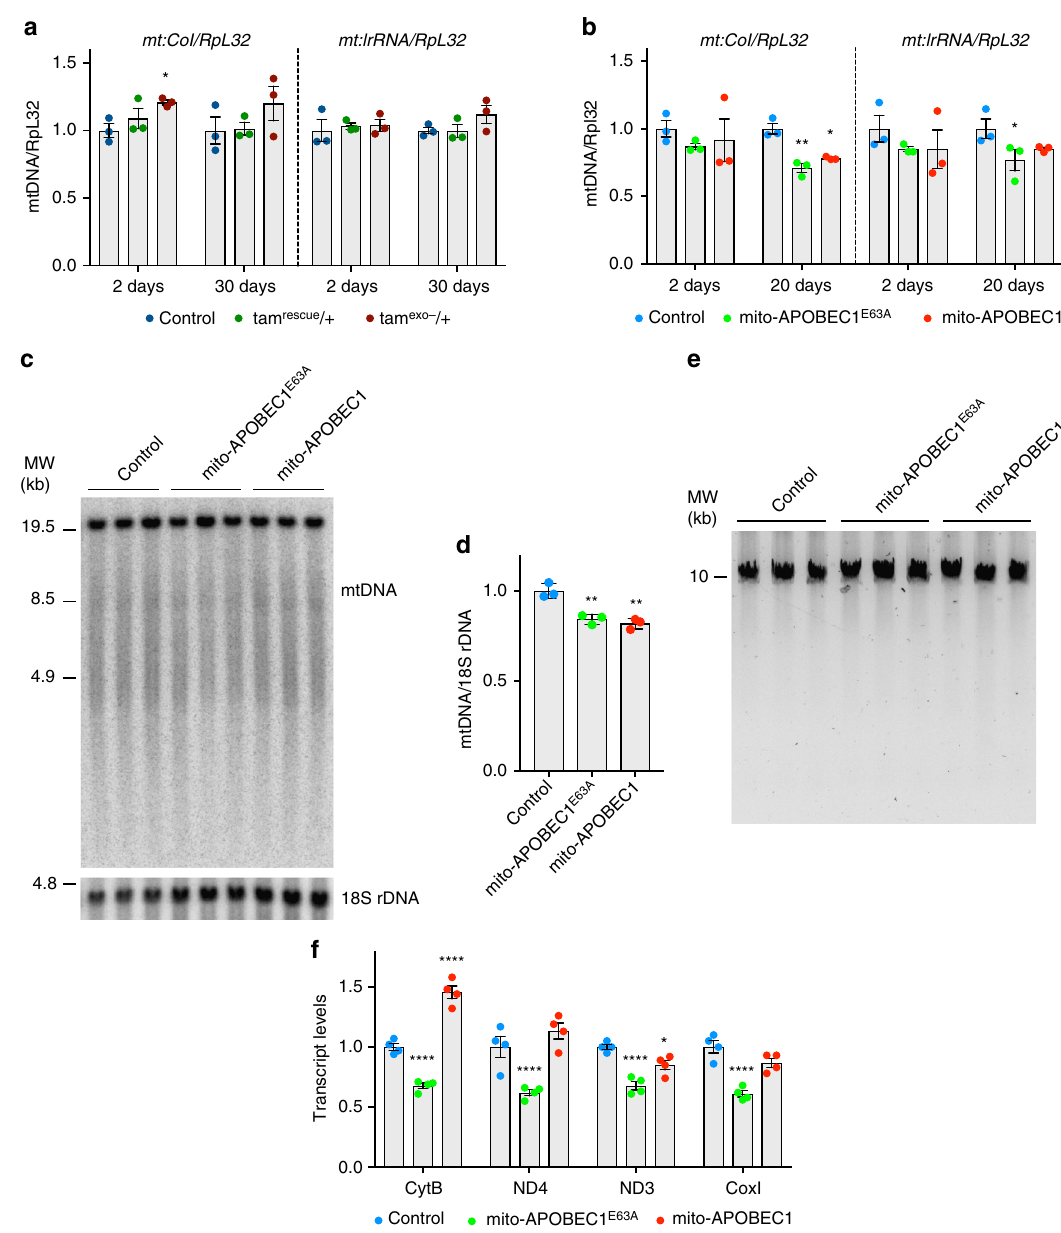
Fig. 3 Analysis of mtDNA levels and integrity. mtDNA copy number was analysed in 10-day-old a maternally inherited tam exo − and b mito-APOBEC1 mutator fl ies and respective controls by quantitative-PCR of two regions of the mitochondrial genome ( mt:CoI and mt:lrRNA ) against the level of nuclear gene, RpL32 . Charts show means ± SEM, n = 3 biologically independent samples; data points indicate independent experiments. Statistical analysis used two-way ANOVA with Tukey ’ s multiple comparison test. * P < 0.05, ** P < 0.01. c Southern blot, quanti fi ed in ( d) , and e long-range PCR analyses further con fi rm mtDNA integrity and levels in mito-APOBEC1 fl ies and relative controls. Charts in d show means ± SD, n = 3 biologically independent